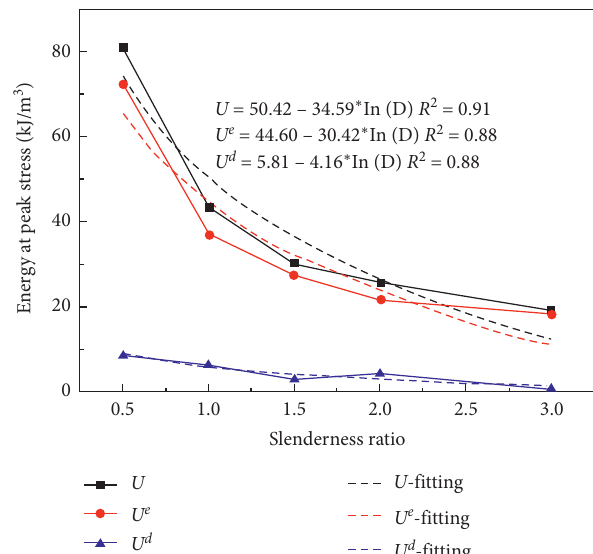
Figure 10: Energy at peak stress versus slenderness